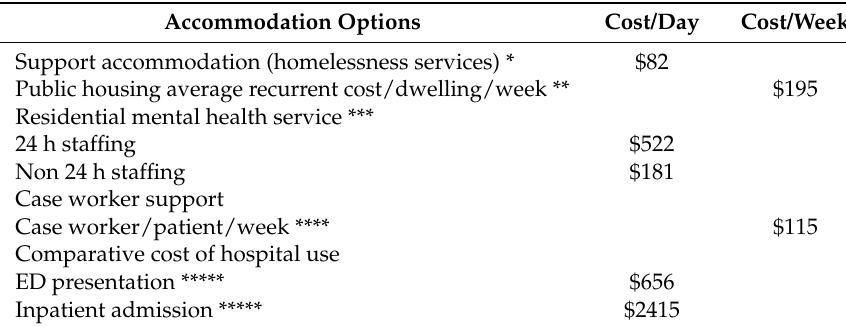
Table 4. Accommodation and case worker cost